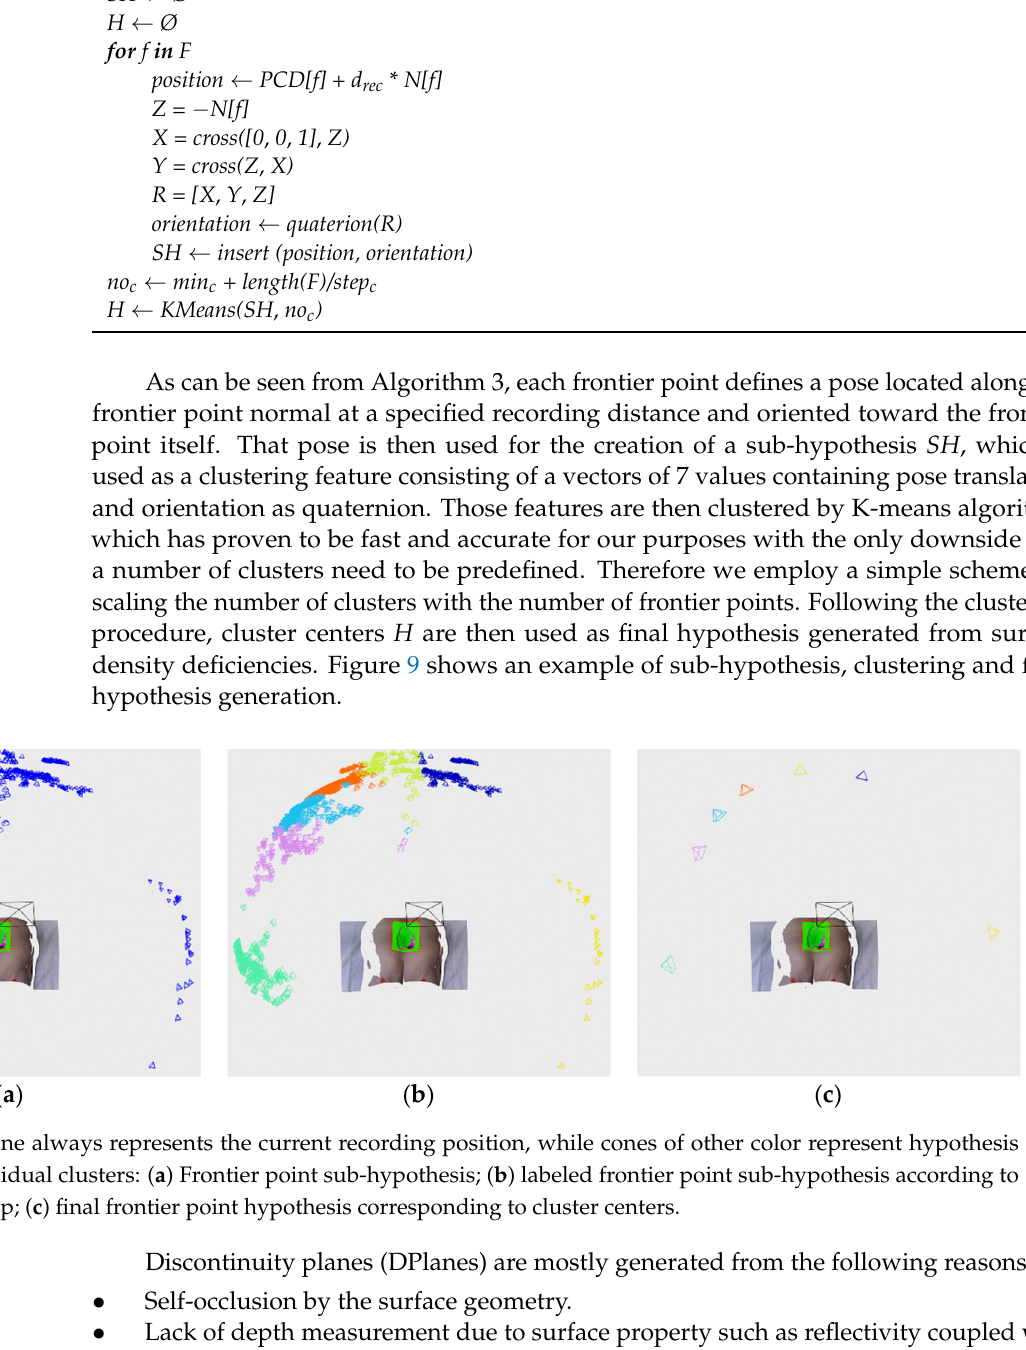
Algorithm 3. Algorithm for Creating Recording Hypothesis from Frontier Point Data